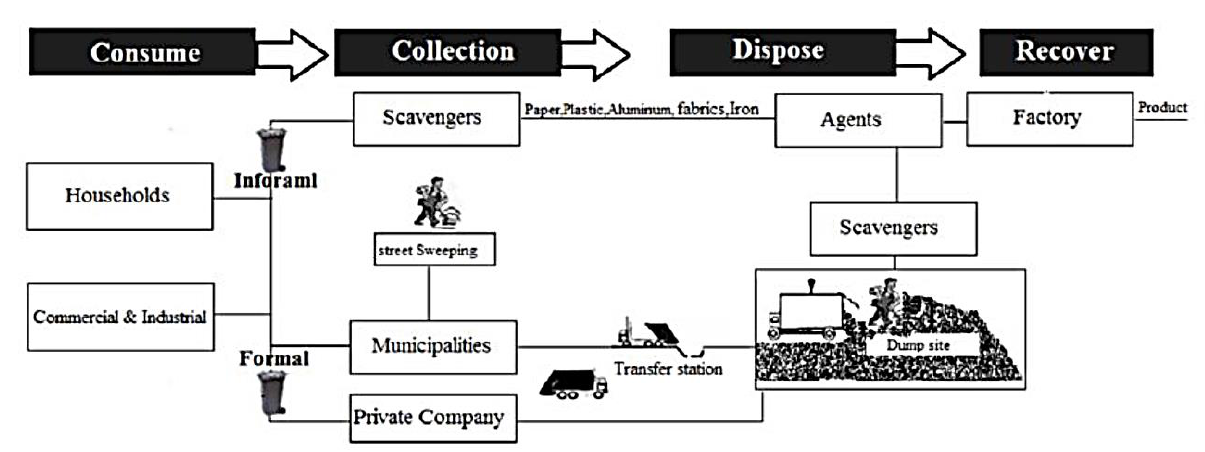
Figure 3: Flow chart for MSW streams and waste pickers’ role in Jordan from Tafila Case Study [4].